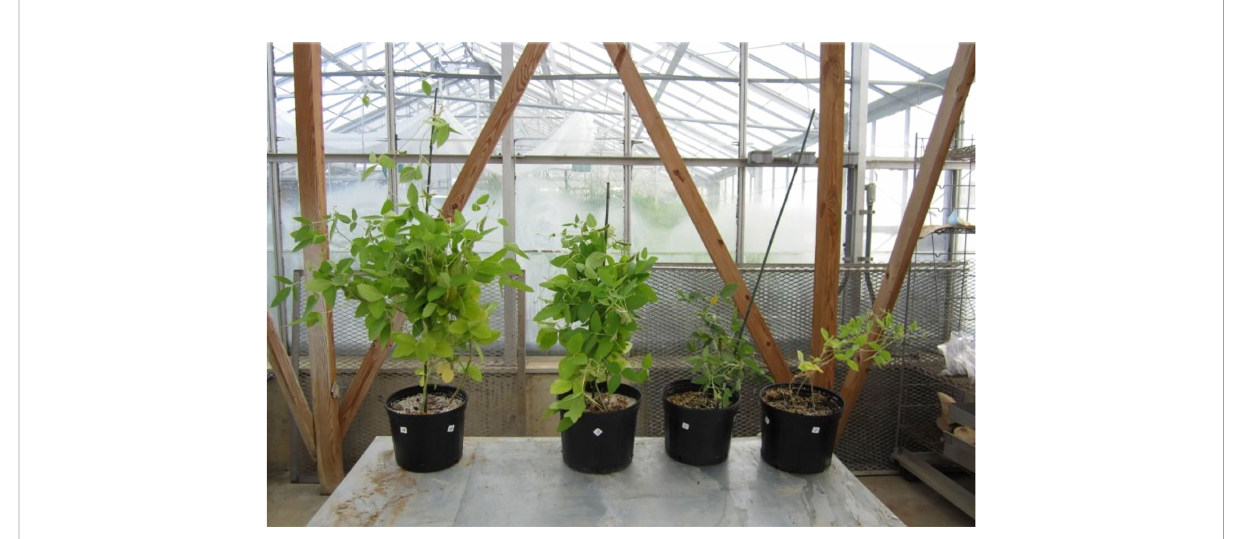
FIGURE 7 Soybean plant growth 15 weeks after germination under different fertilizer treatments (left to right) Hydroxyapatite ENMs (Engineered Nanomaterials), fertilizer plus normal phosphorous, fertilizer without phosphorous, and water (Liu and Lal, 2014). Copyright